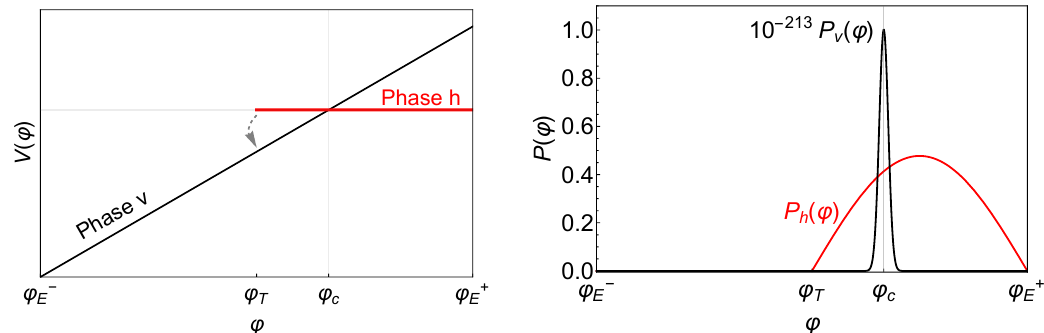
Figure 5 . Left panel. A sketch of the scalar potential of the waterfall scheme. The two branches v and h are degenerate in energy at a generic field value ϕ , but transitions between them occur only c at ϕ = ϕ . Right panel. The asymptotic volume-weighted distribution in phase v (in black and T multiplied by a reduction factor of 10 − 213 ) and phase h (in red) for α = 10 − 5 , β = 10 3 , ϕ = 1 and k = k = 1 (the value of ϕ − is inconsequential for the result). The distribution ϕ c = 0 , ϕ + v h E E is dominantly found in phase v , peaked near ϕ = ϕ c